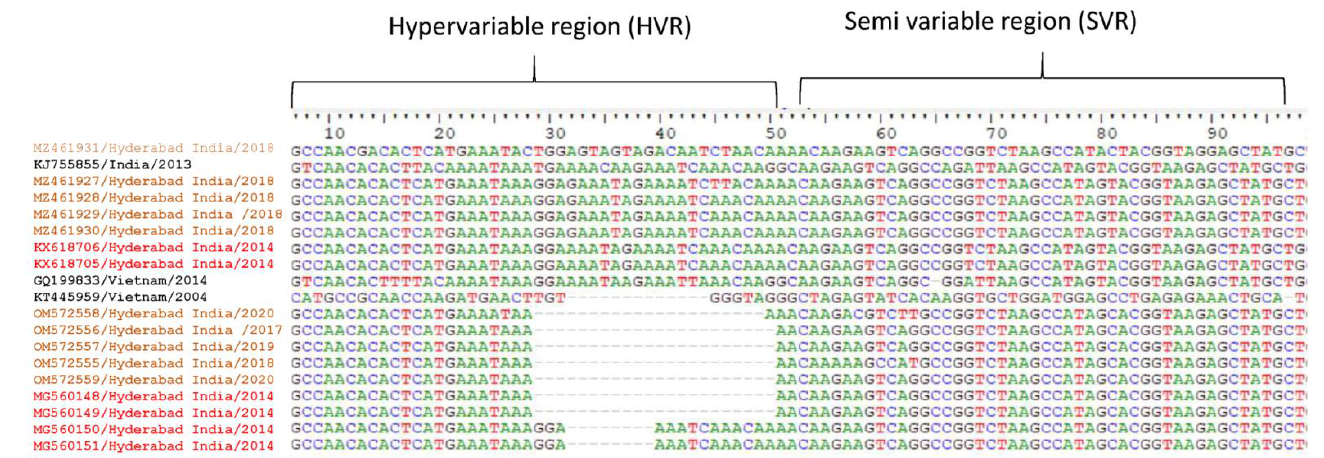
Figure 4. Comparative nucleotide sequence alignment using DENV-1 3′ UTR sequences obtained from the NCBI database (black) and the sequences identified from the present study (orange), along with previous sequences from the laboratory (red).